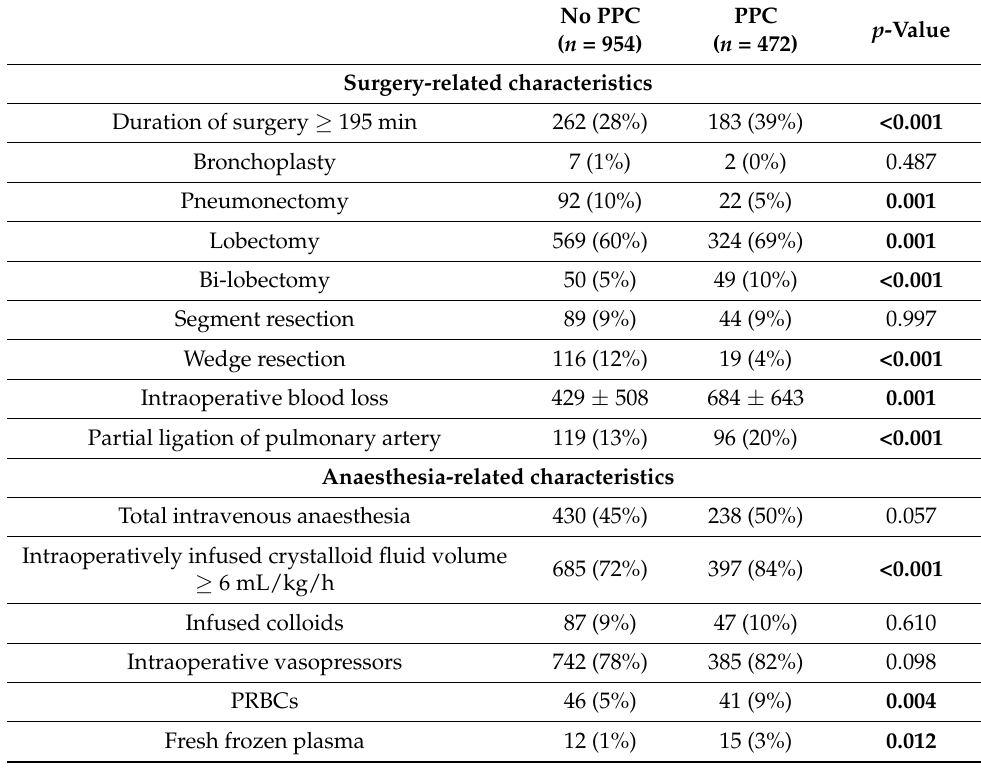
Table 2. Univariate analysis of surgery- and anaesthesia-related characteristics that led to risk factors for PPCs in patients undergoing open thoracotomy lung resection due to primary lung cancer. The data are presented as the number of patients (percentage) or median (interquartile range). PPC = postoperative pulmonary complication; PRBCs = packed red blood cells; OLV = one-lung ventilation; PEEP = positive end-expiratory